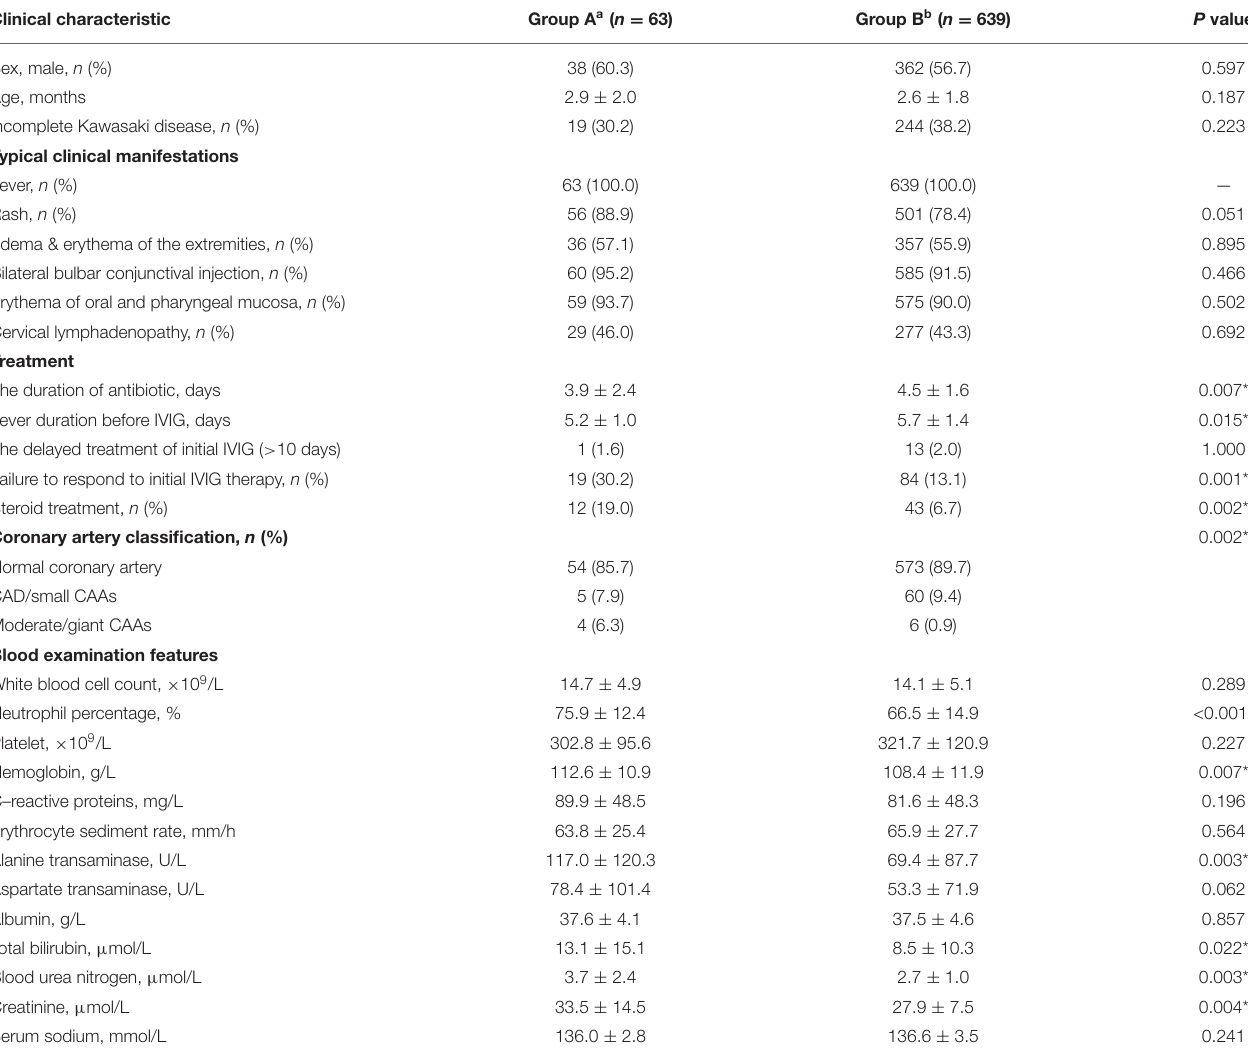
TABLE 2 | The comparison of demographic, clinical characteristic and laboratory results of Kawasaki disease between patients with sterile pyuria and without. Clinical